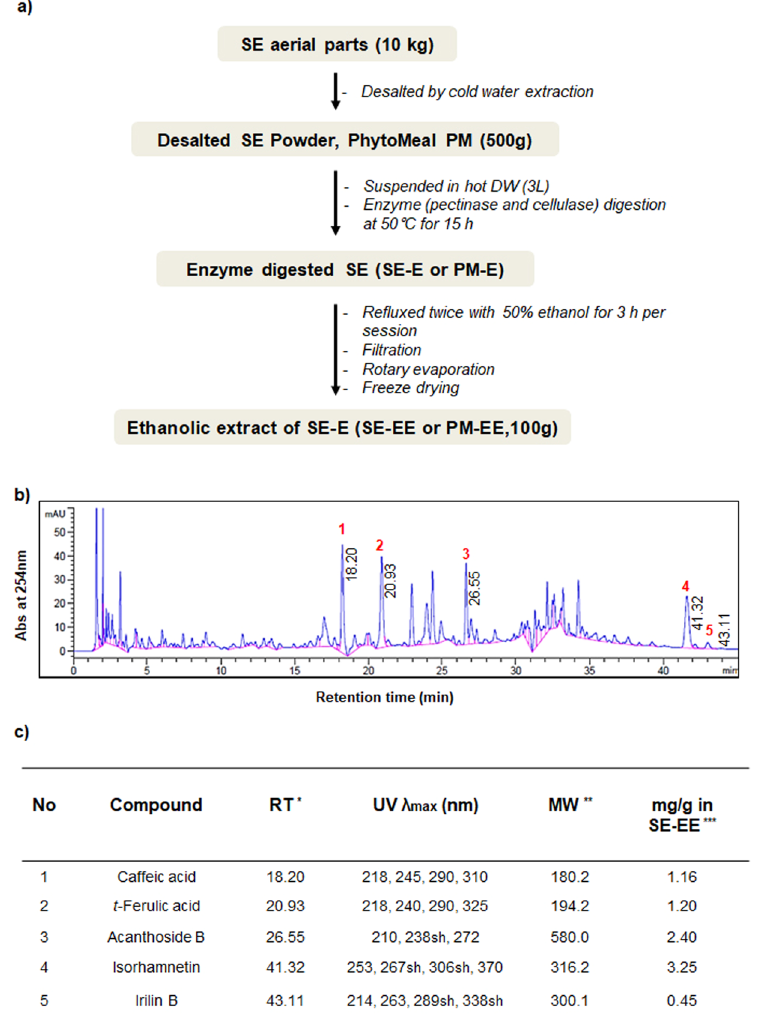
Figure 1. SE-EE preparation and chromatographic profile: ( a ) Schematic representation of the SE-EE preparation procedure; ( b ) representative HPLC chromatogram of SE-EE acquired from the desalted Salicornia europaea ; ( c ) Tabulation of the identified compounds from the chromatographic profile of